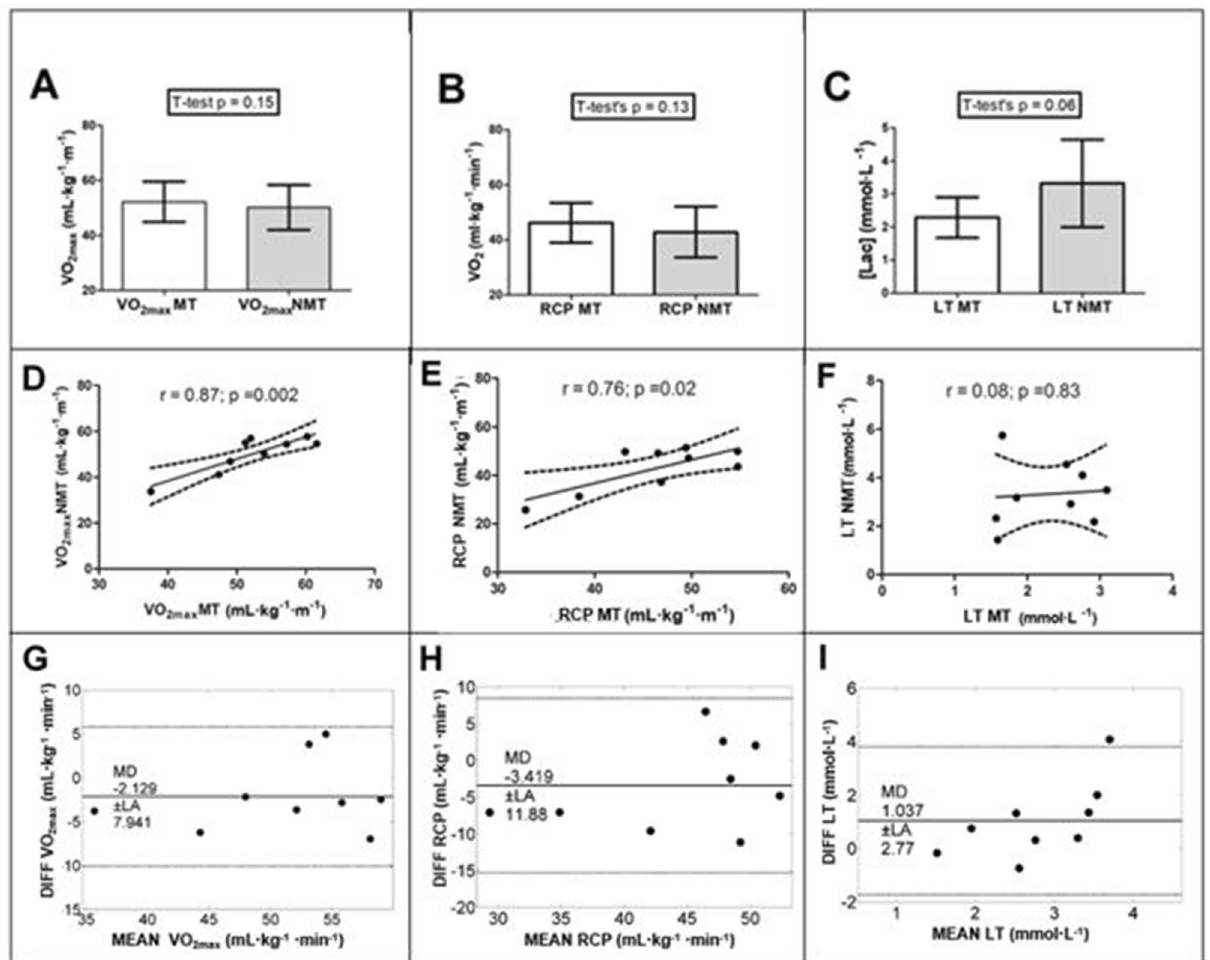
˙ V ˙ V Figure 4. Comparison of O 2max ( A ), O 2 in iRCP ( B ) and [Lac] values in iLT ( C ) between the incremental tests in different ergometers, with their respective correlation ( D–F ) and Bland Altman plots ( G–I ); [Lac] blood lactate concentration, iRCP second metabolic threshold intensity determined by respiratory parameters, ˙ V iLT second metabolic threshold intensity determined by lactate; O 2max maximal oxygen consumption, MT motorized treadmill, NMT nonmotorized